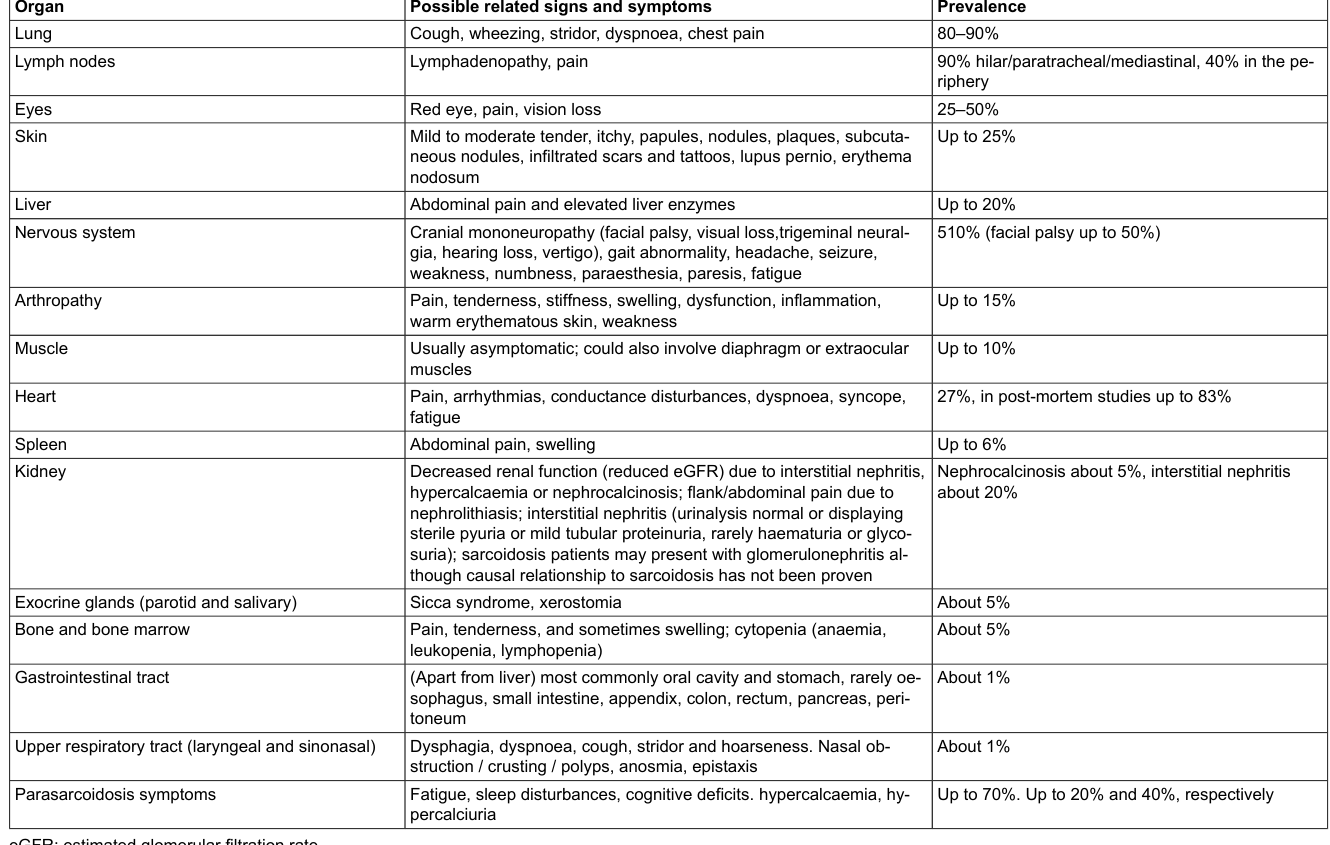
Table 1: Organ involvements and symptoms in sarcoidosis.